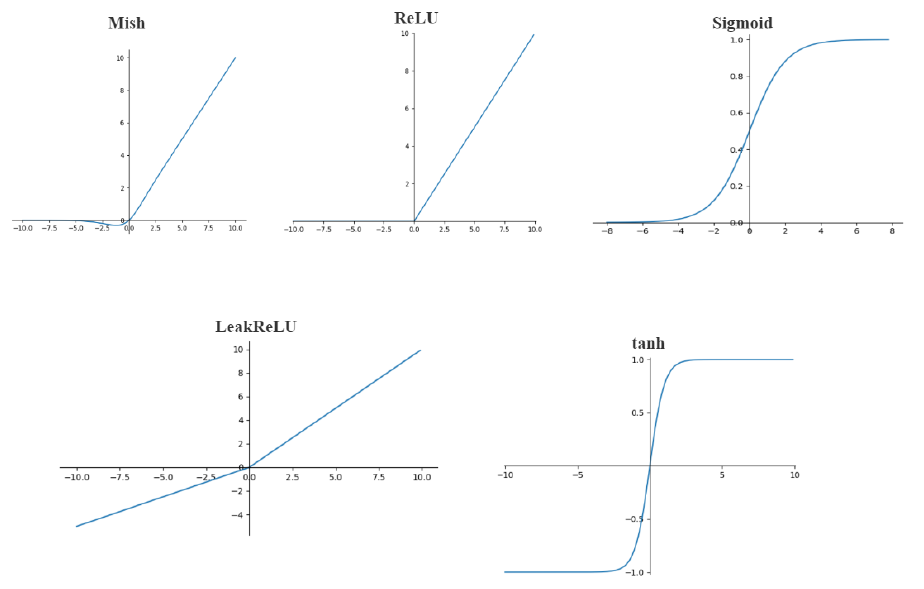
Figure 8. Base activation functions.